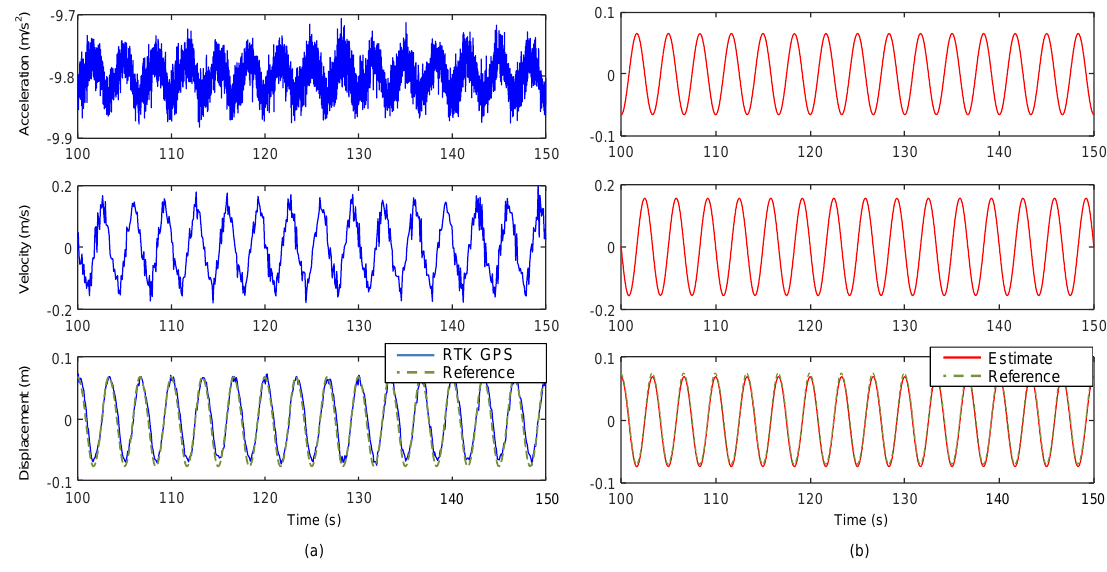
Figure 9. Comparison of measurements before and after applying two-stage Kalman filter (for 0.3Hz sinusoidal vibration input in Case 1): ( a ) initial acceleration from accelerometer, velocity from GPS, displacement from RTK-GPS before applying Kalman filter; ( b ) corresponding estimated responses from the proposed measurement system after applying Kalman filter.